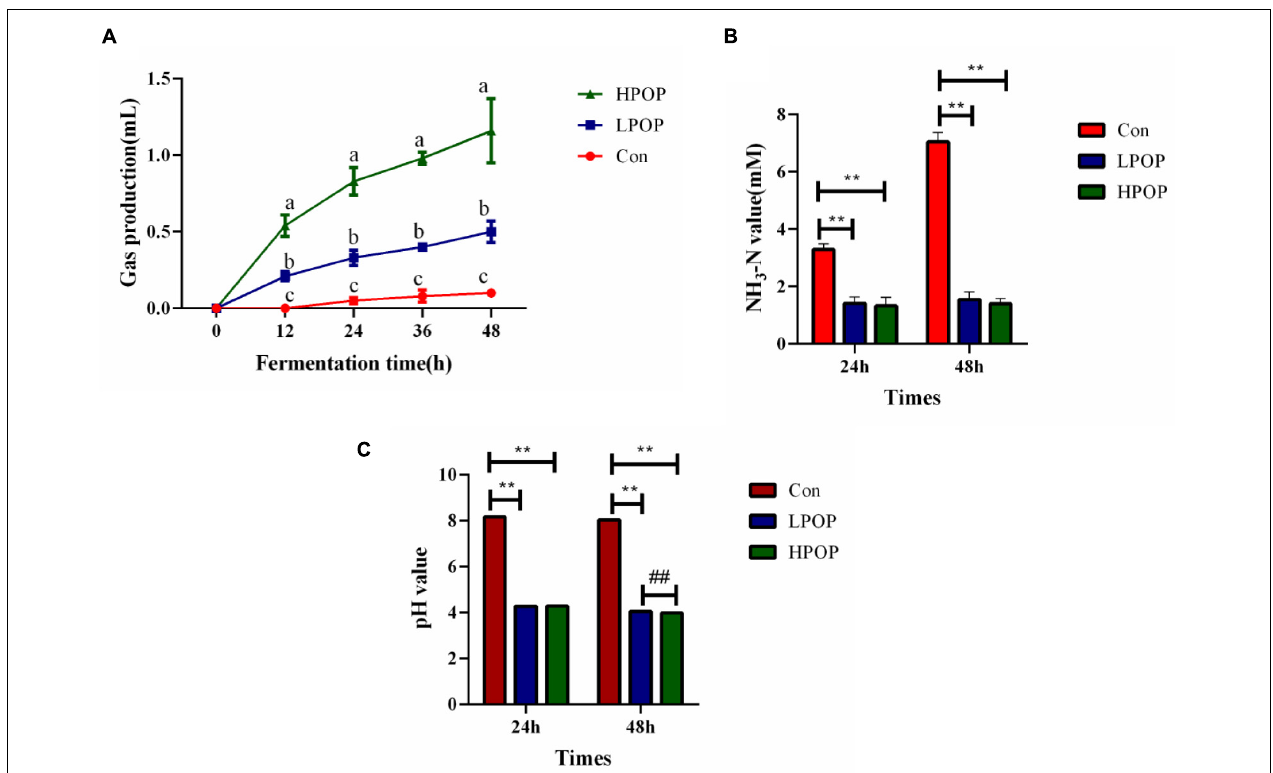
FIGURE 1 | Gas production of the anaerobic cultures was recorded at 0, 12, 24, 36, and 48 h post inoculation (hpi), and the fermentation culture was collected at 24 and 48 hpi. Supernatants of the culture were separated by centrifugation for detection of pH and ammonia nitrogen levels. Gas production, NH 3 -N, and pH value during 48 h in vitro fecal fermentation with POP. (A) Gas production. (B) NH 3 -N. ** P < 0.01 and ## P < 0.01 vs different groups, respectively. (C) pH